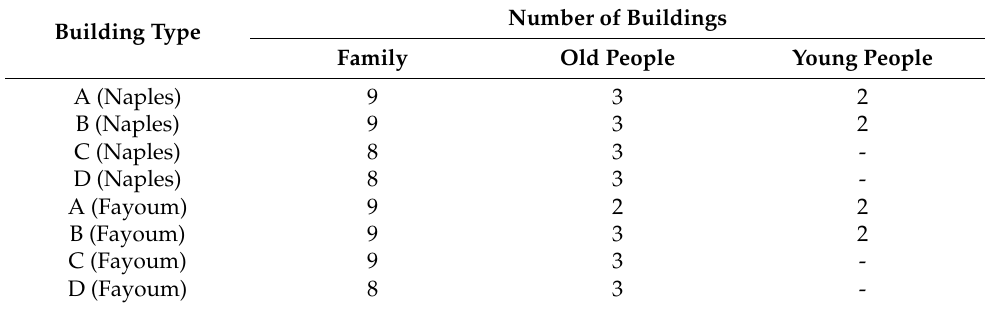
Table 3. Occupancy characteristics of the district buildings for Naples and Fayoum.